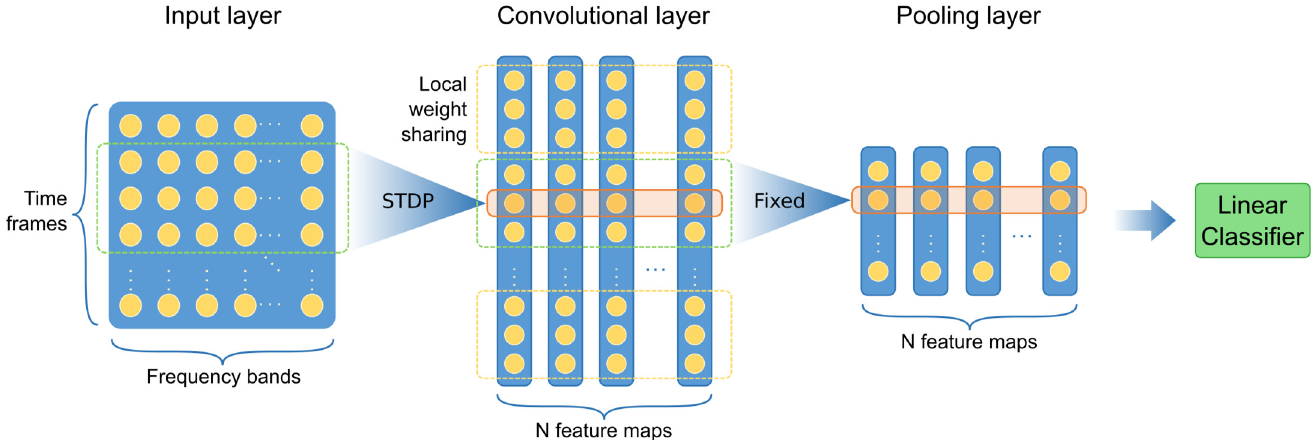
Fig 1. Architecture of proposed spiking neural network (SNN). The network consists of an input layer, a convolutional layer, and a pooling layer. The input layer converts the Mel-Frequency Spectral Coefficients (MFSC) of speech signal into spikes using the time-to-first-spike coding scheme. The convolutional layer contains multi features maps which are responsible for detecting different features, and their input weights are learned by spike-timing-dependent plasticity (STDP). Each feature map in the convolutional layer is divided into non-overlapping sections which have shared input weights. The pooling layer compresses the output of the convolutional layer, and its output is classified by a linear